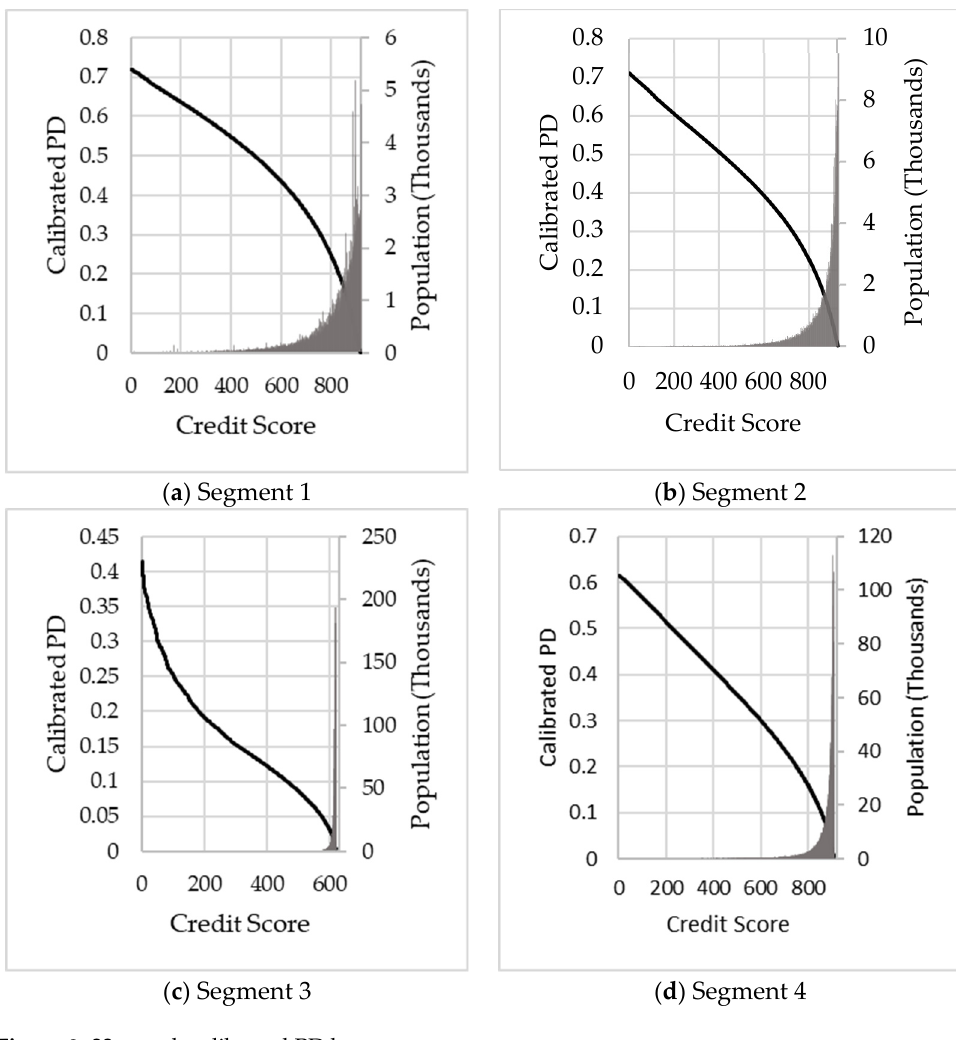
Figure 9. 22 month calibrated PD by score. Table 7. Illustration of scaling factors for Segment 1.